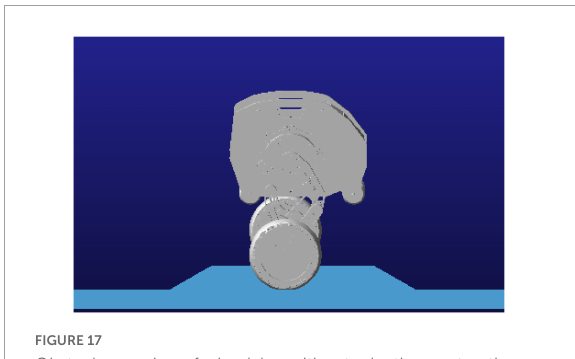
FIGURE16 Left and right motor location diagram.